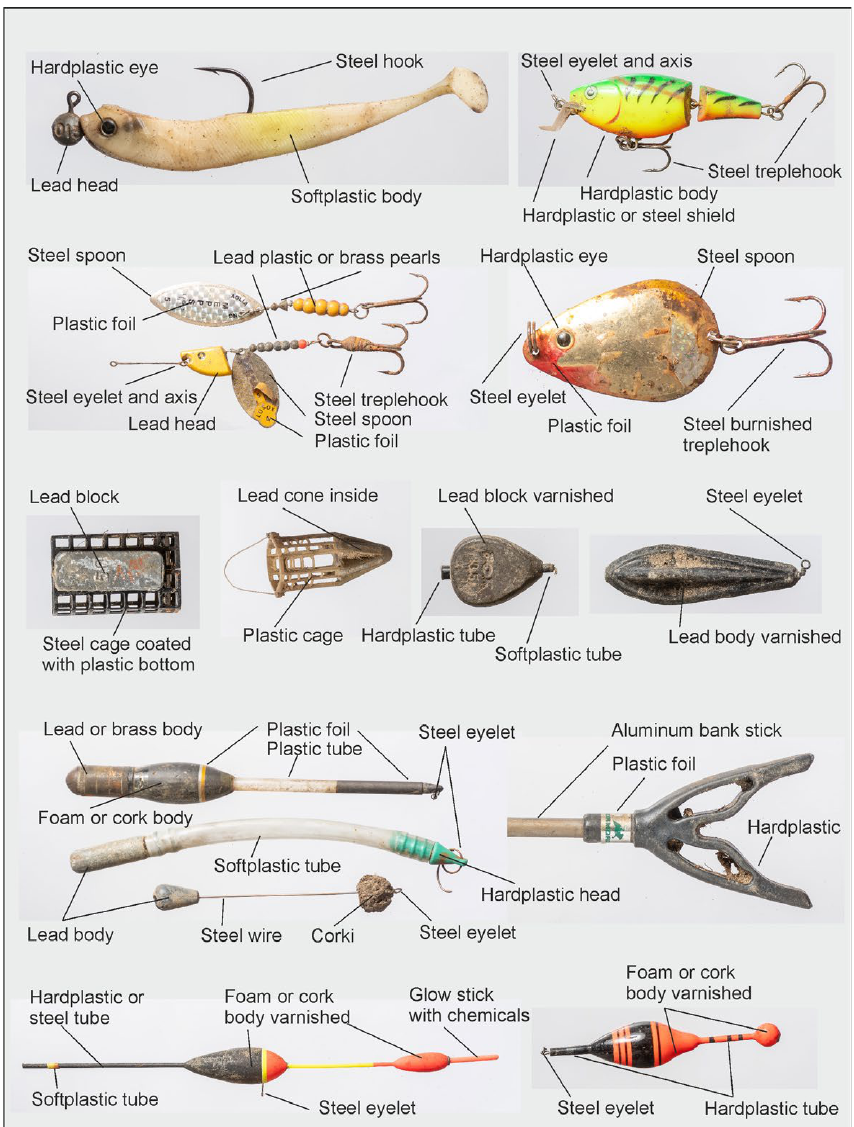
Figure 4. Examples of collected angling items in Lake Eixendorf that represent compound materials. Note that steel materials can also contain nickel or zinc and that all plastic items were solely classified as soft plastic or hard plastic. We are aware that these materials can widely differ in their chemical Table 2. Identified components of lost fishing tackle found in Lake Eixendorf. Note that some of the materials, e.g., “steel”, can consist of several components including zinc or nickel. The same holds true for fishing lines that can consist of either polyamide, polyethylene, or other polymers. Mean = mean weight per item, min = minimum weight per item, max = maximum weight per item, n = number of items containing the substance.